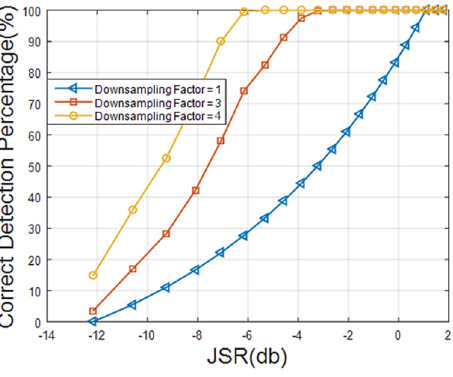
( b ) Figure 13. Correct detection percentage based on the input JSR (detector with the simplified Welch method); ( a ) downsampling = 2; ( b ) downsampling = 4. As it is mentioned before, benefiting from the averaging, the proposed design has a unique capability in weak signal detection. Machine learning and artificial intelligence techniques are able to classify the type of interference and they cannot estimate the center